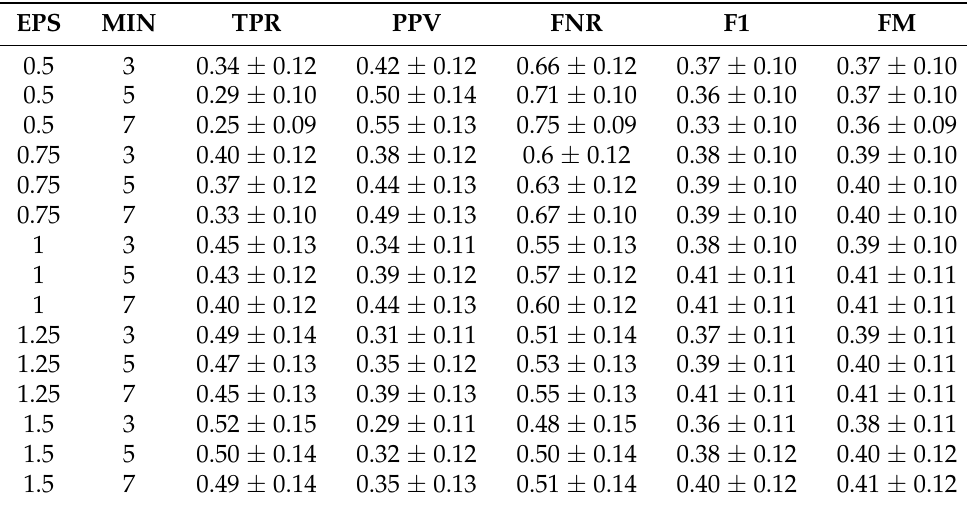
Table 5. Evaluation results of SLAM-OR (MobileNet) algorithm depending of DBSCAN parame- ters setup.